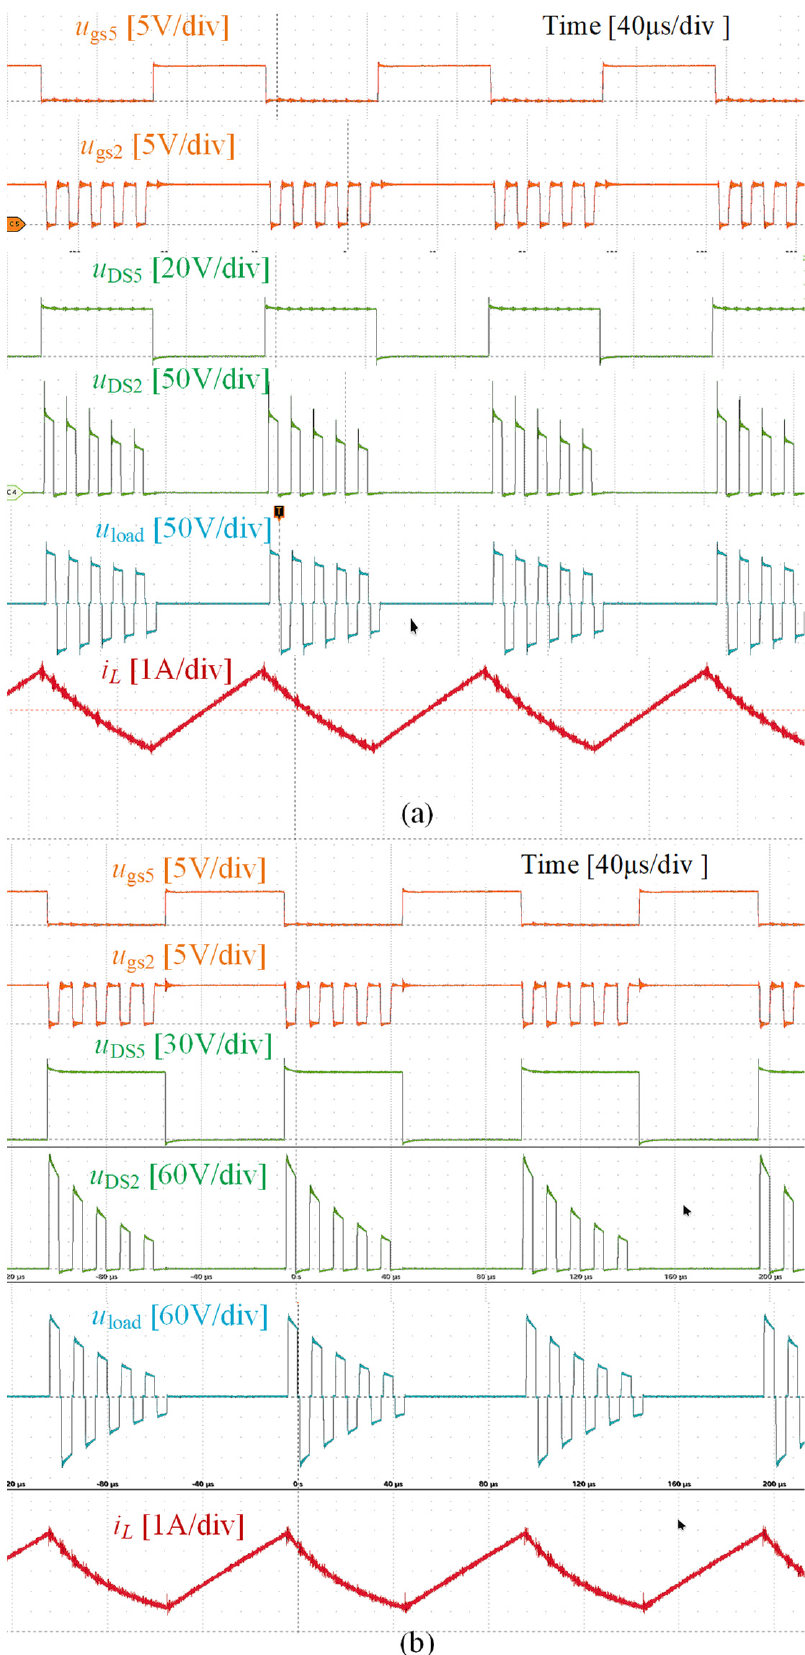
Figure 19. The experimental waveforms of the all-SiC-based CSI: ( a ) R load = 20 Ω , and ( b ) R load = 50 Ω Figure 20. The experimental waveforms of the all-SiC-based CSI: ( a ) R load = 20 Ω , and ( b ) R load = 50 Ω . The power loss and efficiencies were measured by a power analyzer, and the efficien- cies of the CSI were measured when the load resistance was 10, 20, 50, and 100 Ω . Moreo- ver, the inductor losses that were measured were involved. According to the experimental results, the efficiency versus the output power could be plotted as shown in Figure 21. The curves based on the calculated and simulation results are also given for comparison, where the inductor loss of the calculation and simulation results were thought to be equal to the experimental results.